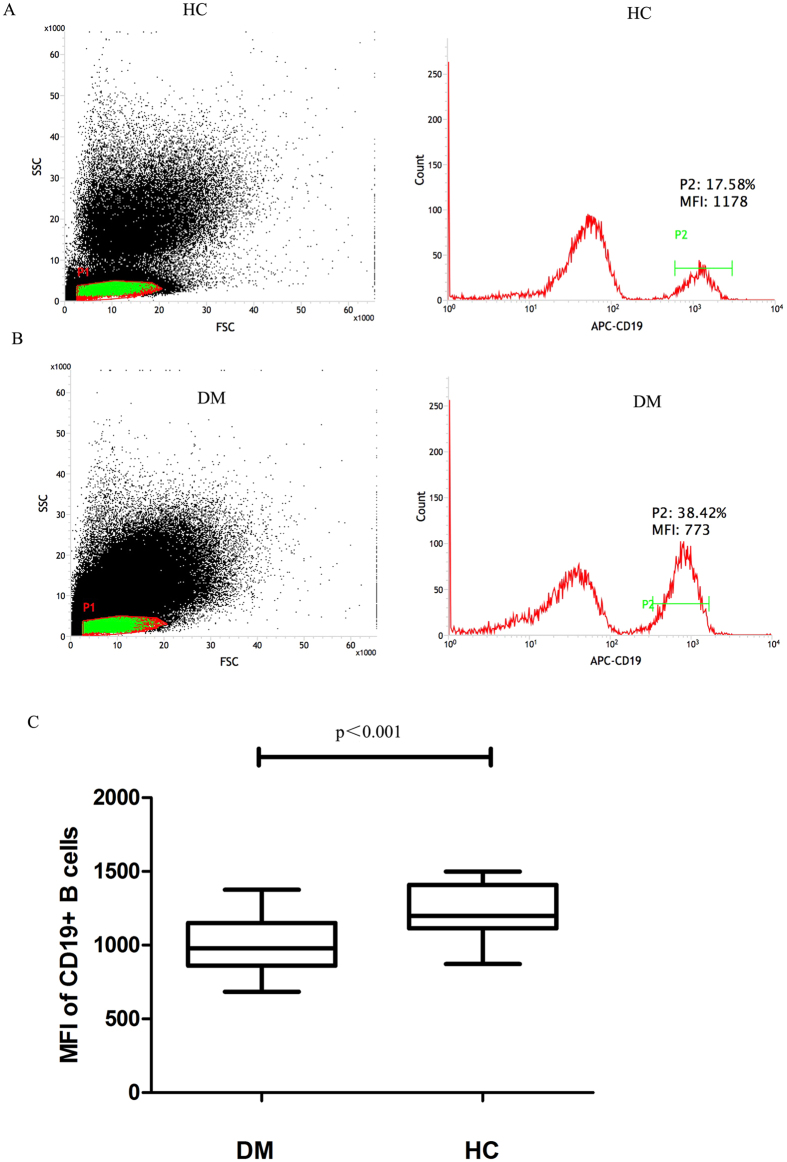
CD19 expression in B cells. Comparing CD19 MFI of B cells between patients with DM and HCs.(A,B) In these representative cases, obviously, the mean percentages of total B cell is higher in the DM patient than in the healthy individual (38.42% vs 17.58%). CD19 expression is lower among all the B cells of the DM patient compared to that of the healthy control (MFI: 773 vs 1178). (C) The mean CD19 MFI expression of B cells was significantly decreased in the DM group compared to the healthy control group (mean MFI: 999 ± 40.69 vs 1222 ± 42.75, p < 0.001).